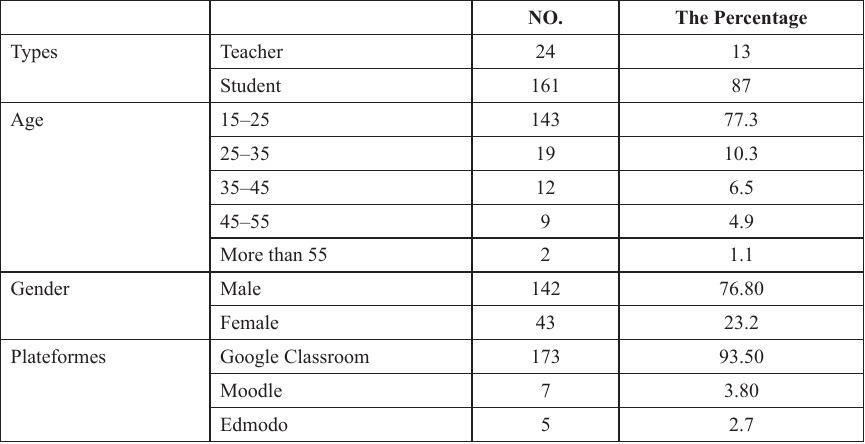
Table 1. Descriptive analysis—profile of respondents NO. The